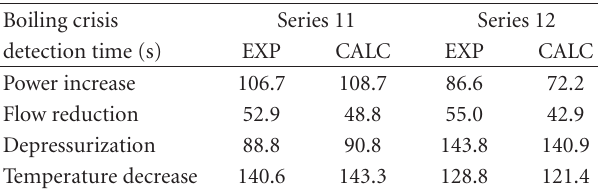
Table 9: Comparison between calculated and experimental boiling crisis detection